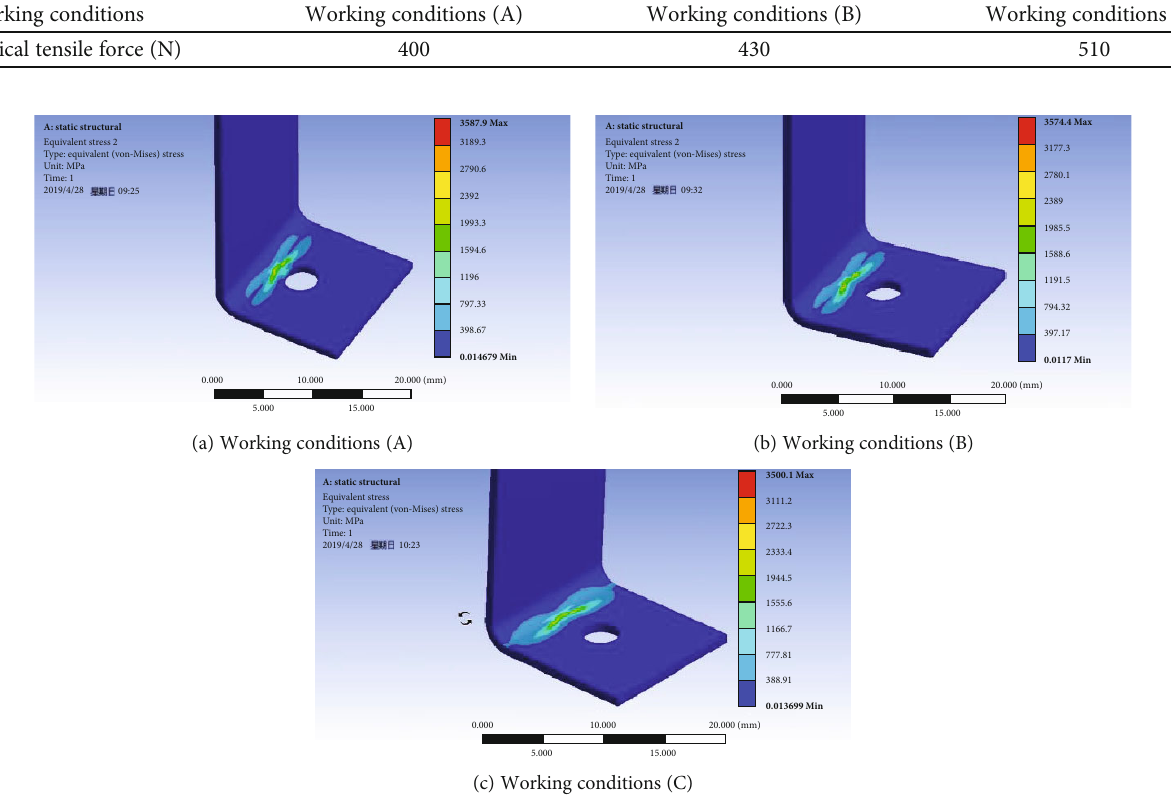
Table 9: The critical tensile force of the kevlar ribbon corresponding to the diameter of di ff erent riveting joints.